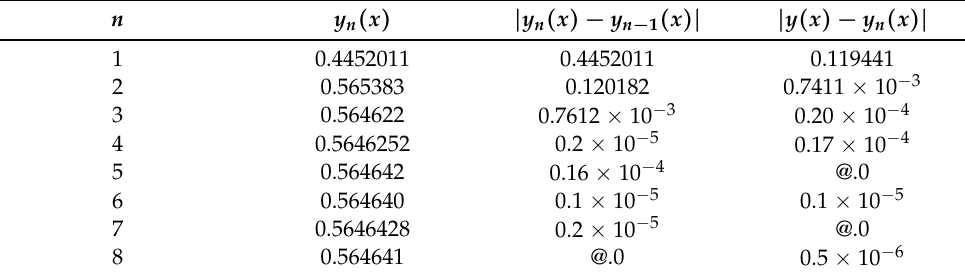
Table 9. Results of the CESTAC method for Example 3 and x =